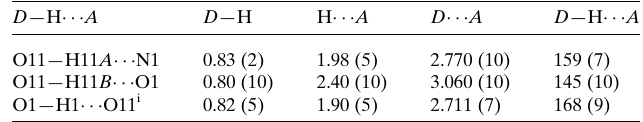
Table 1 Hydrogen-bond geometry (A˚ , (cid:5)